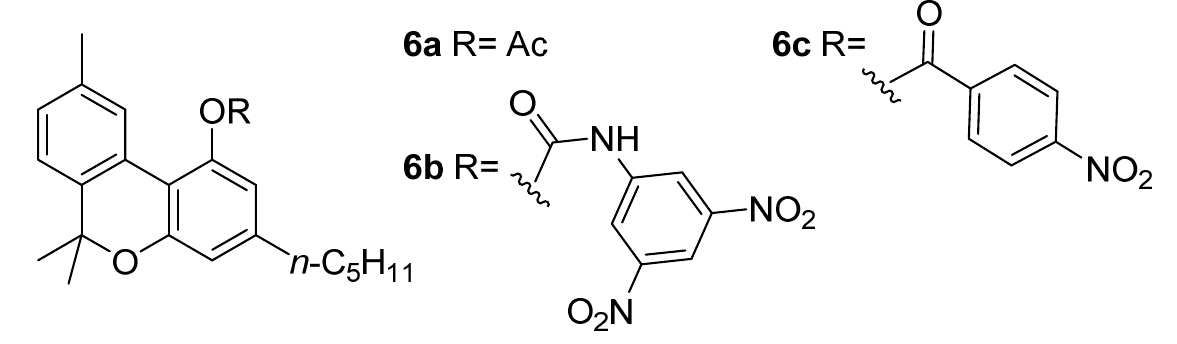
Figure 2. The structures of CBN adducts used for its isolation and characterization: CBN-acetate ( 6a ), CBN-3,5-dinitrophenylurethane ( 6b ) and CBN-4-nitrophenyl ester ( 6c ).